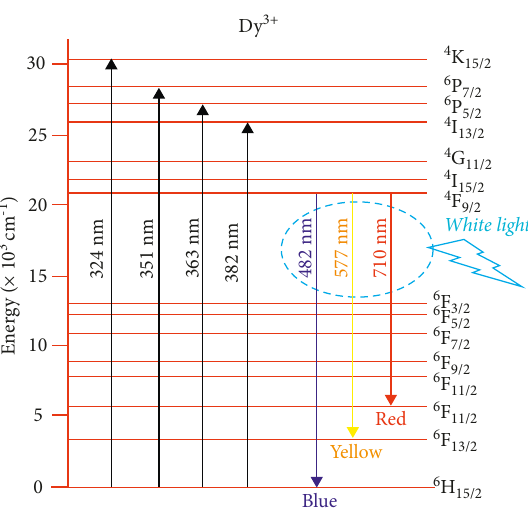
Figure 6: Energy level diagram of the activator (Dy 3+ ions) in the silicate host (Ba